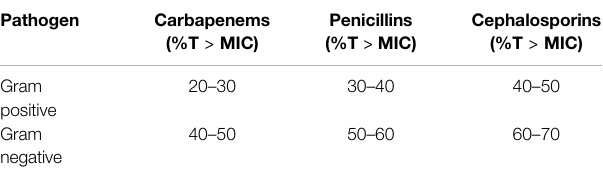
TABLE 1 | A summary of the range of the percentage time above the minimal inhibitory concentration (%T > MIC) for carbapenems, penicillins, and cephalosporins for Gram-positive and Gram negative pathogens is depicted (Craig, 1997; Craig, 1998; Ambrose et al.,